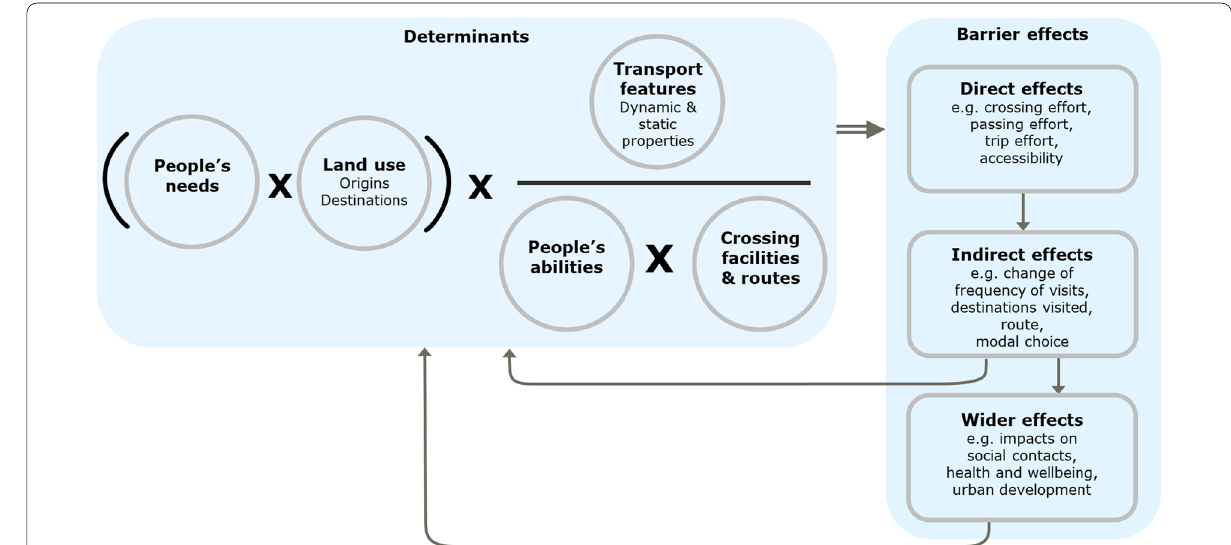
Fig. 1 Conceptual model of the barrier effects of transport infrastructure and